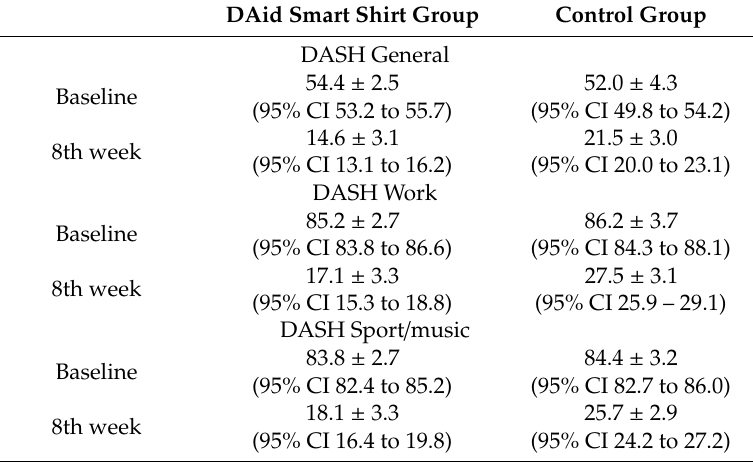
Table 2. The Disabilities of the Arm, Shoulder, and Hand (DASH) pre- and post-treatment score, mean, SD, and